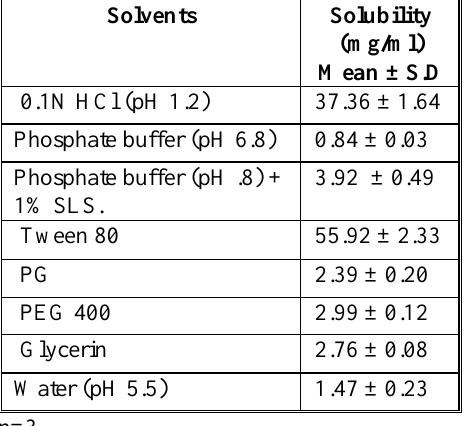
Table 2. Solubility of clopidogrel bisulfate in various